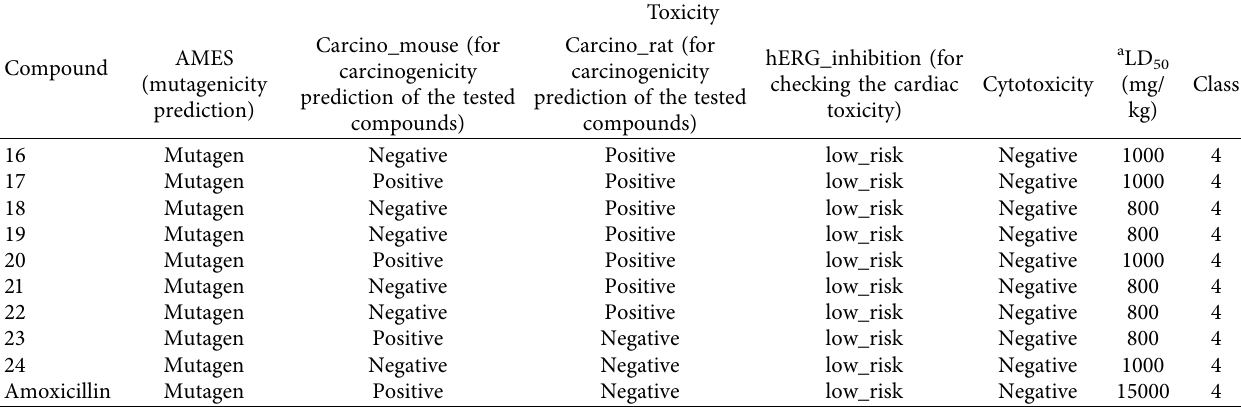
a LD 50 : lethal dose